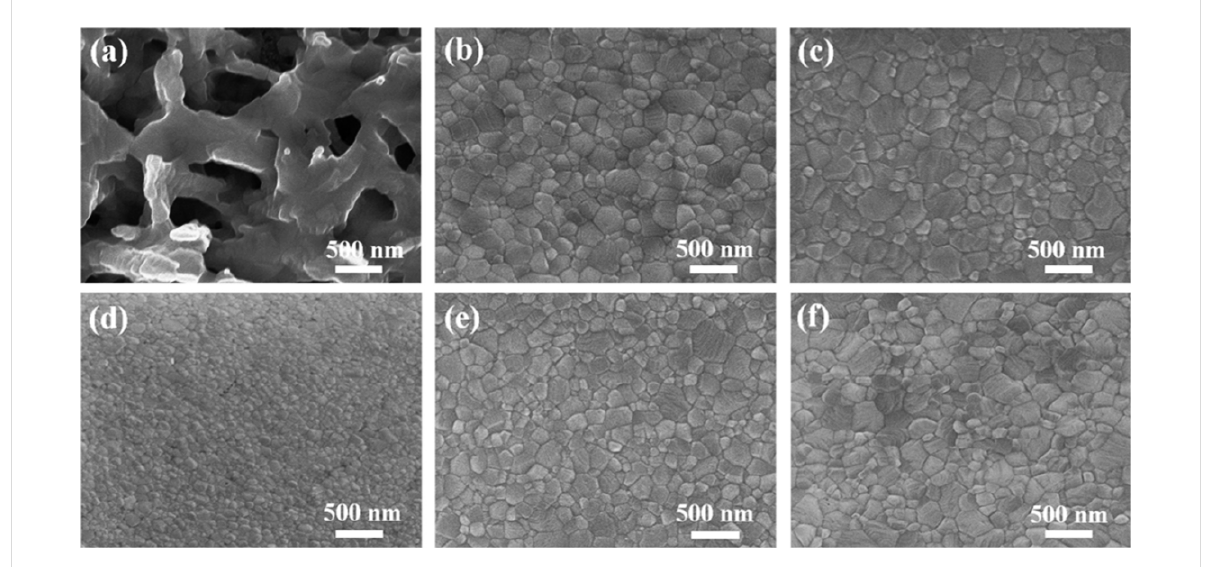
Figure 2: Scanning electron microscopy images of perovskite films prepared by the antisolvent deposition method treated with different solvents: (a) without antisolvent, (b) toluene, (c) chlorobenzene, (d) chloroform, (e) diethyl ether and (f) di-isopropyl ether. Reproduced with permission